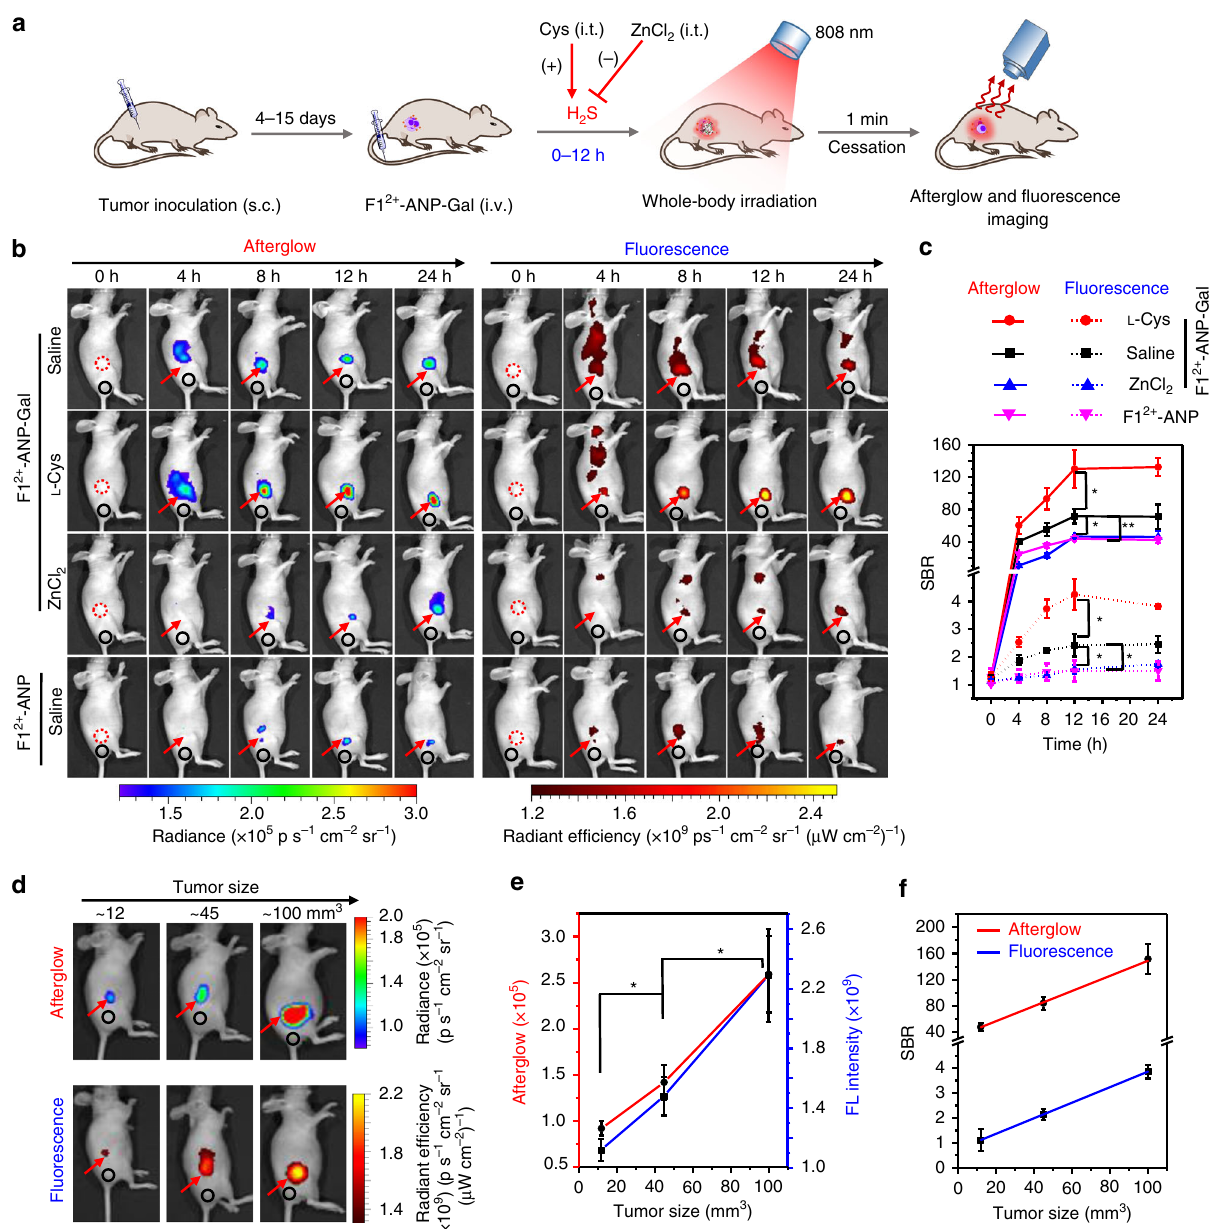
Fig. 4 Afterglow imaging of H 2 S in s.c. HepG2 tumors. a Schematic for noninvasive fl uorescence and afterglow imaging of H 2 S in HepG2 tumor-bearing mice. b Afterglow (left) and fl uorescence (right) imaging of HepG2 tumors in mice at 0, 4, 8, 12, and 24 h following i.v. injection of F1 2 + -ANP-Gal or F1 2 + - ANP in saline (saline), F1 2 + -ANP-Gal with i.t. injection of L -Cys or ZnCl 2 . L -Cys (1 mM, 25 µ L) or ZnCl 2 (1 mM, 25 µ L) was injected into tumors at 3.5 h post i.v. injection of F1 2 + -ANP-Gal (211/100/8 μ g F1 2 + (BF 4 − ) 2 /MEH-PPV/NIR775, 200 μ L). c Quanti fi cation of SBRs for afterglow (solid) and fl uorescence (dash) imaging of HepG2 tumors in mice treated with F1 2 + -ANP-Gal or F1 2 + -ANP alone, F1 2 + -ANP-Gal plus L -Cys, or ZnCl 2 at indicated time point. d Afterglow (up) and fl uorescence (down) imaging of HepG2 tumors at size of ~12, ~45, and ~100 mm 3 in mice at 12 h post i.v. injection of F1 2 + -ANP-Gal. e Quanti fi cation of afterglow and fl uorescence intensities of HepG2 tumors at different size. f Plots of the SBRs for afterglow and fl uorescence imaging versus the tumor size revealed a strong correlation for F1 2 + -ANP-Gal (Person ’ s r = 0.99). For afterglow imaging, the mouse body was irradiated with the 808-nm laser (1 W cm − 2 ) for 1 min. After cessation of laser, the afterglow images were acquired for 60 s with an open fi lter. The fl uorescence images were acquired with λ ex/em = 740/790nm. Red arrows indicate the locations of HepG2 tumors in mice, and black circles indicate the background locations. Data denote mean ± s.d. (* P < 0.05, ** P < 0.01, n = 3). Statistical differences were analyzed by Student ’ s t test. Source data are provided as a Source Data fi